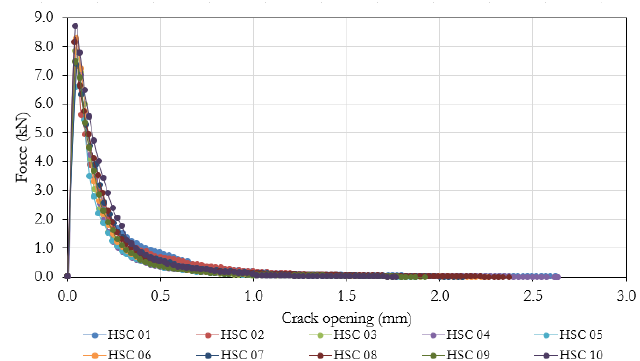
Figure 8. Force versus crack width curves for the high strength concrete.